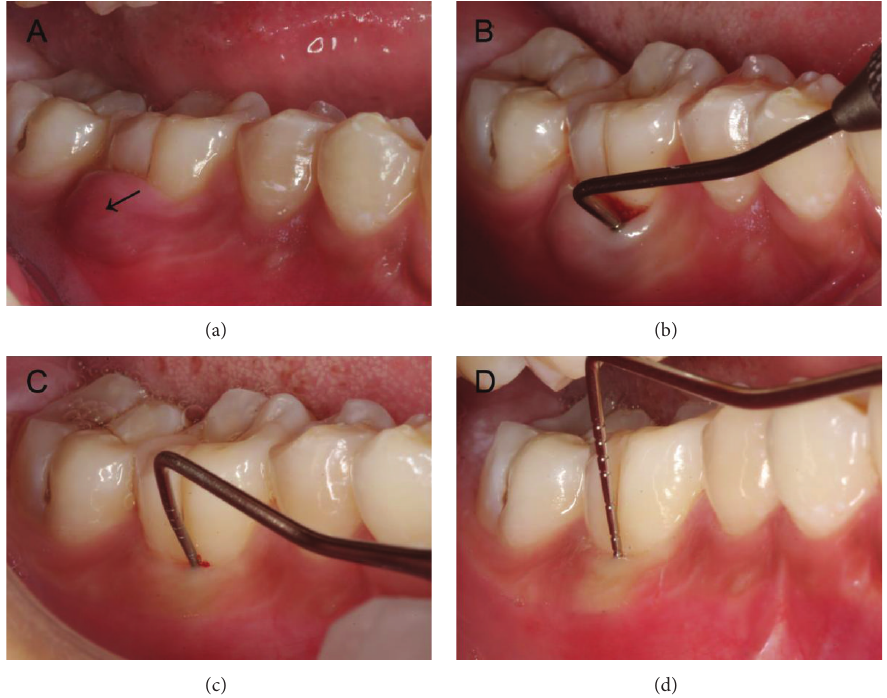
Figure 1: Clinical intraoral photographs. (a) Gingival swelling over the buccal region of tooth 30 (see the dark arrow) and healthy gum of tooth 29. (b) A 10-mm pocket in the buccal furcation of tooth 30 at the initial visit. (c) A 4-mm furcal pocket of tooth 30 in three-month follow-up after operation. (d) At 7-month recall, the furcal probing depth of tooth 30 lessened to about 2mm.